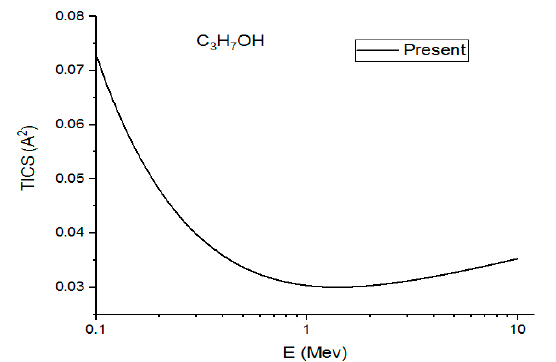
) results of Rieke and Prepejchal [15] for C 2 H 5 OH at a high energy range. (cid:126)